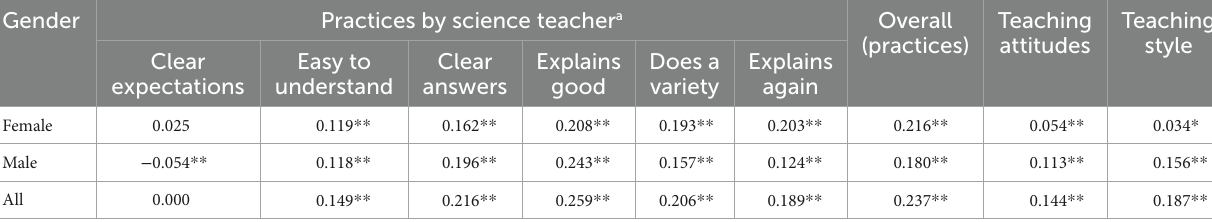
TABLE 4 Practices, style and attitudes correlations with science scores. Gender Practices by science teacher